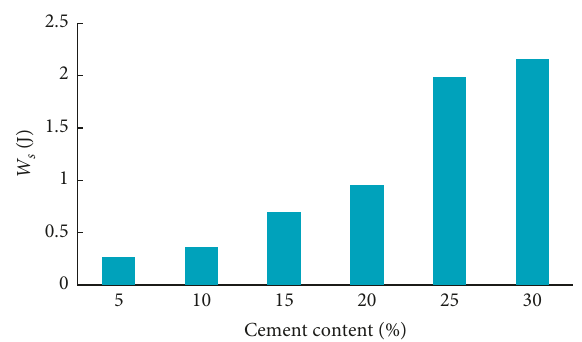
Figure 21: Energy dissipation W